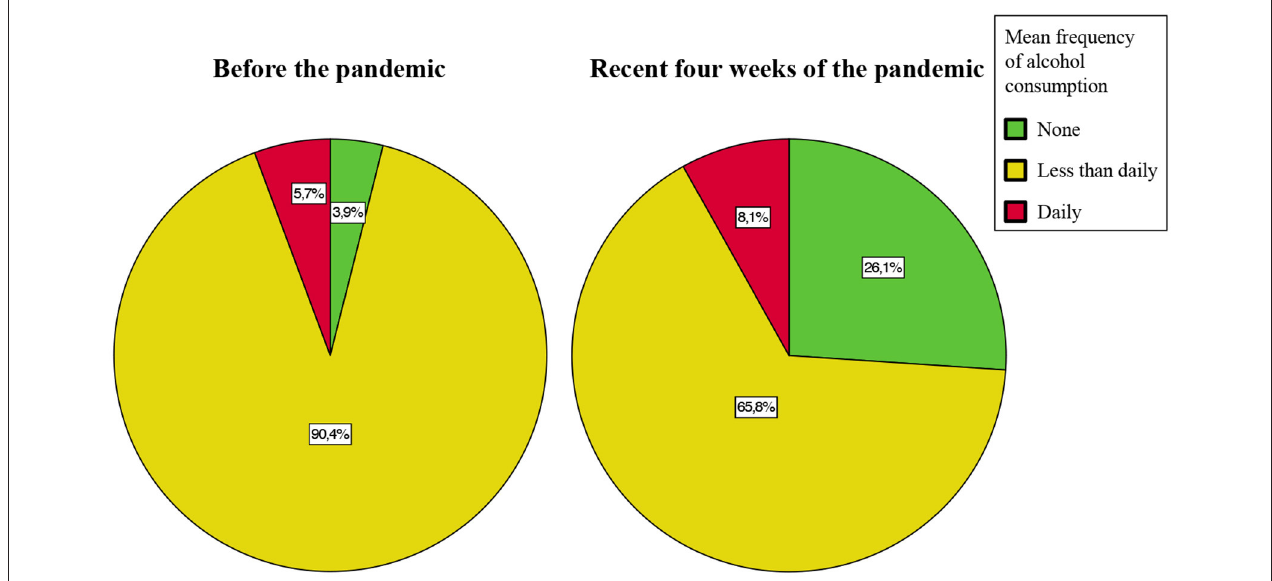
FIGURE 1 | Mean frequency of alcohol consumption during the early COVID-19 pandemic. The pie charts illustrate the mean frequency of alcohol consumption before the pandemic (left) and during the recent 4 weeks of the pandemic (right). Compared to before pandemic, the mean frequency of alcohol consumption decreased during the recent 4 weeks of pandemic. The percentages indicate the proportion of individuals from the sample excl. n = 2 individuals did not report mean frequency of alcohol consumption, i.e., this figure includes data from n = 3,319 individuals. Absolute number are reported in the Supplement 1 .